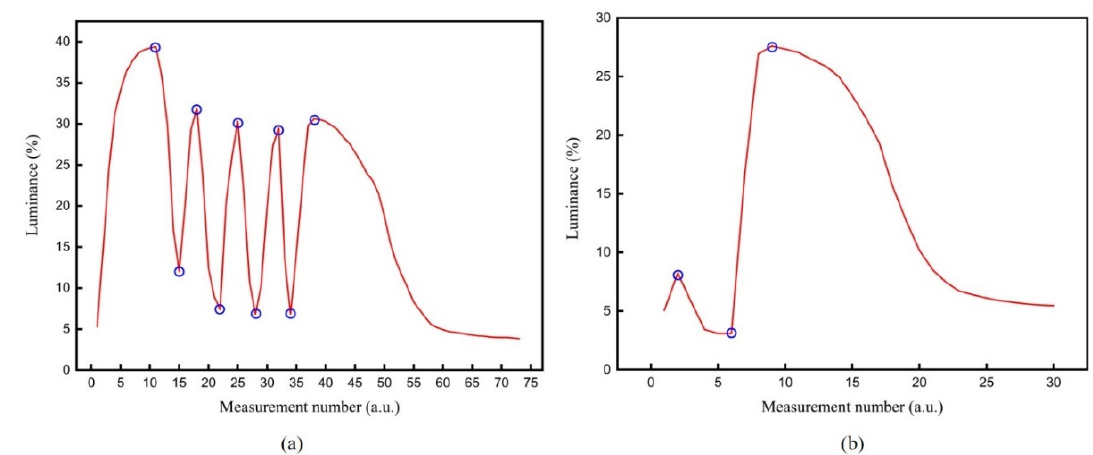
Figure 9. The comparison of flickers between the traditional driving waveform and the proposed driving waveform. ( a ) The luminance curve of the traditional driving waveform. It alternated between bright and dark multiple times. The number of flickers was 9 times, and the maximum intensity was 27.39. ( b ) The luminance curve of the proposed driving waveform. It had fewer peaks, the number of flickers was 3 times, and the maximum intensity of flickers was 24.51.